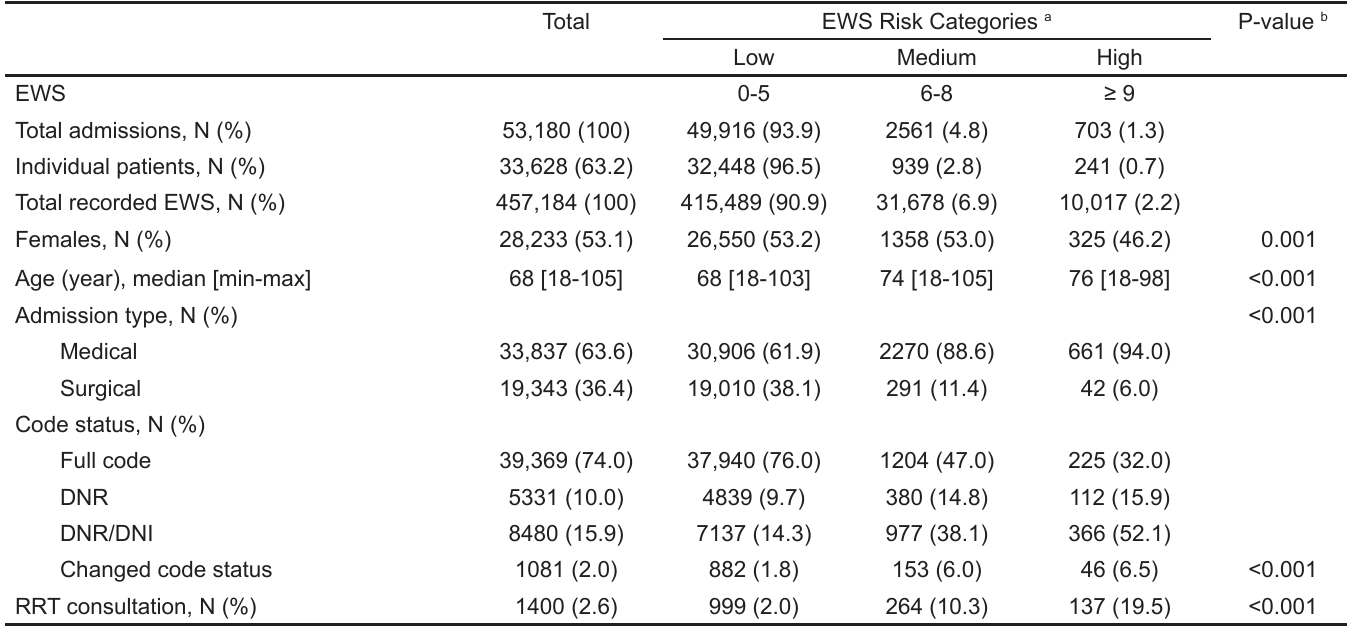
Table 1. Baseline characteristics of the study